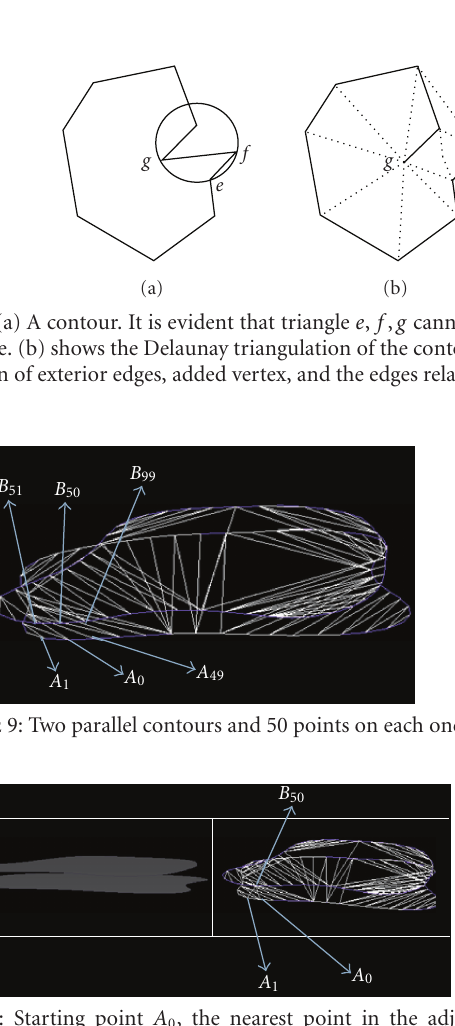
Figure 10: Starting point A 0 , the nearest point in the adjacent contour B 50 , the nearest neighborhood of A 0 in the clockwise direction A 1 , and the triangle A 0 A 1 B 50 .